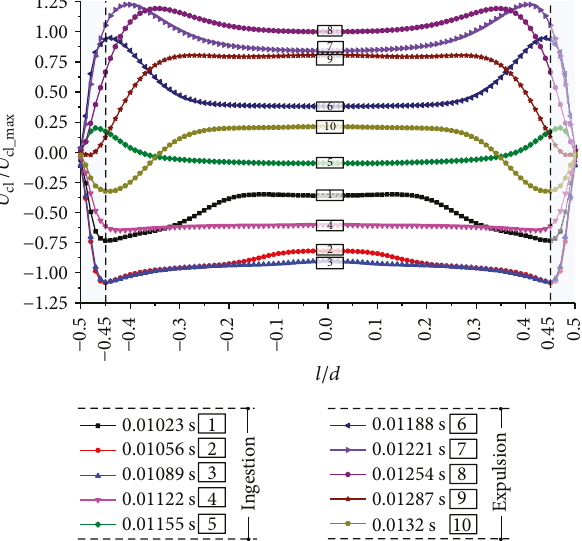
Figure 6: Radial pro fi le of normalized jet velocity at the nozzle exit line in the 4th